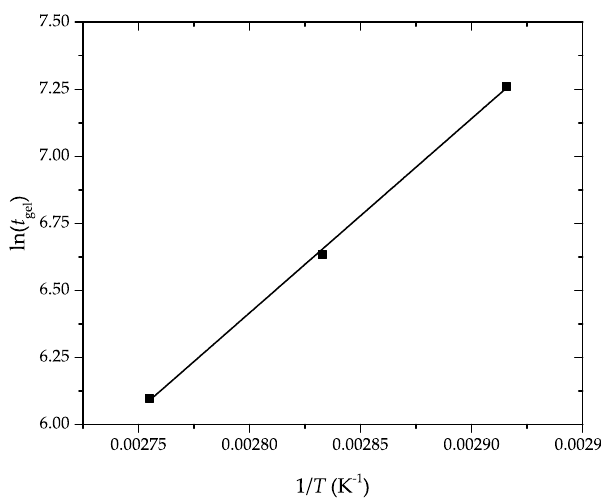
Figure 4. Determination of the apparent activation energy ( E a ) of the partially bio-based epoxy resins by the linear fitting of the gel time versus the inverse temperature, according to Equation 4.